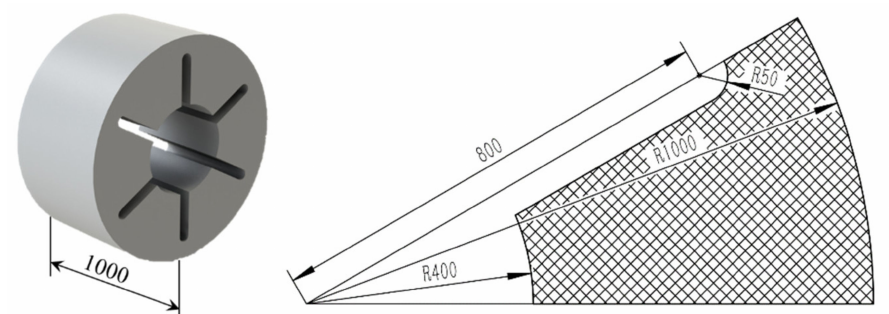
Figure 22. Geometry of the given slotted-tube grain.